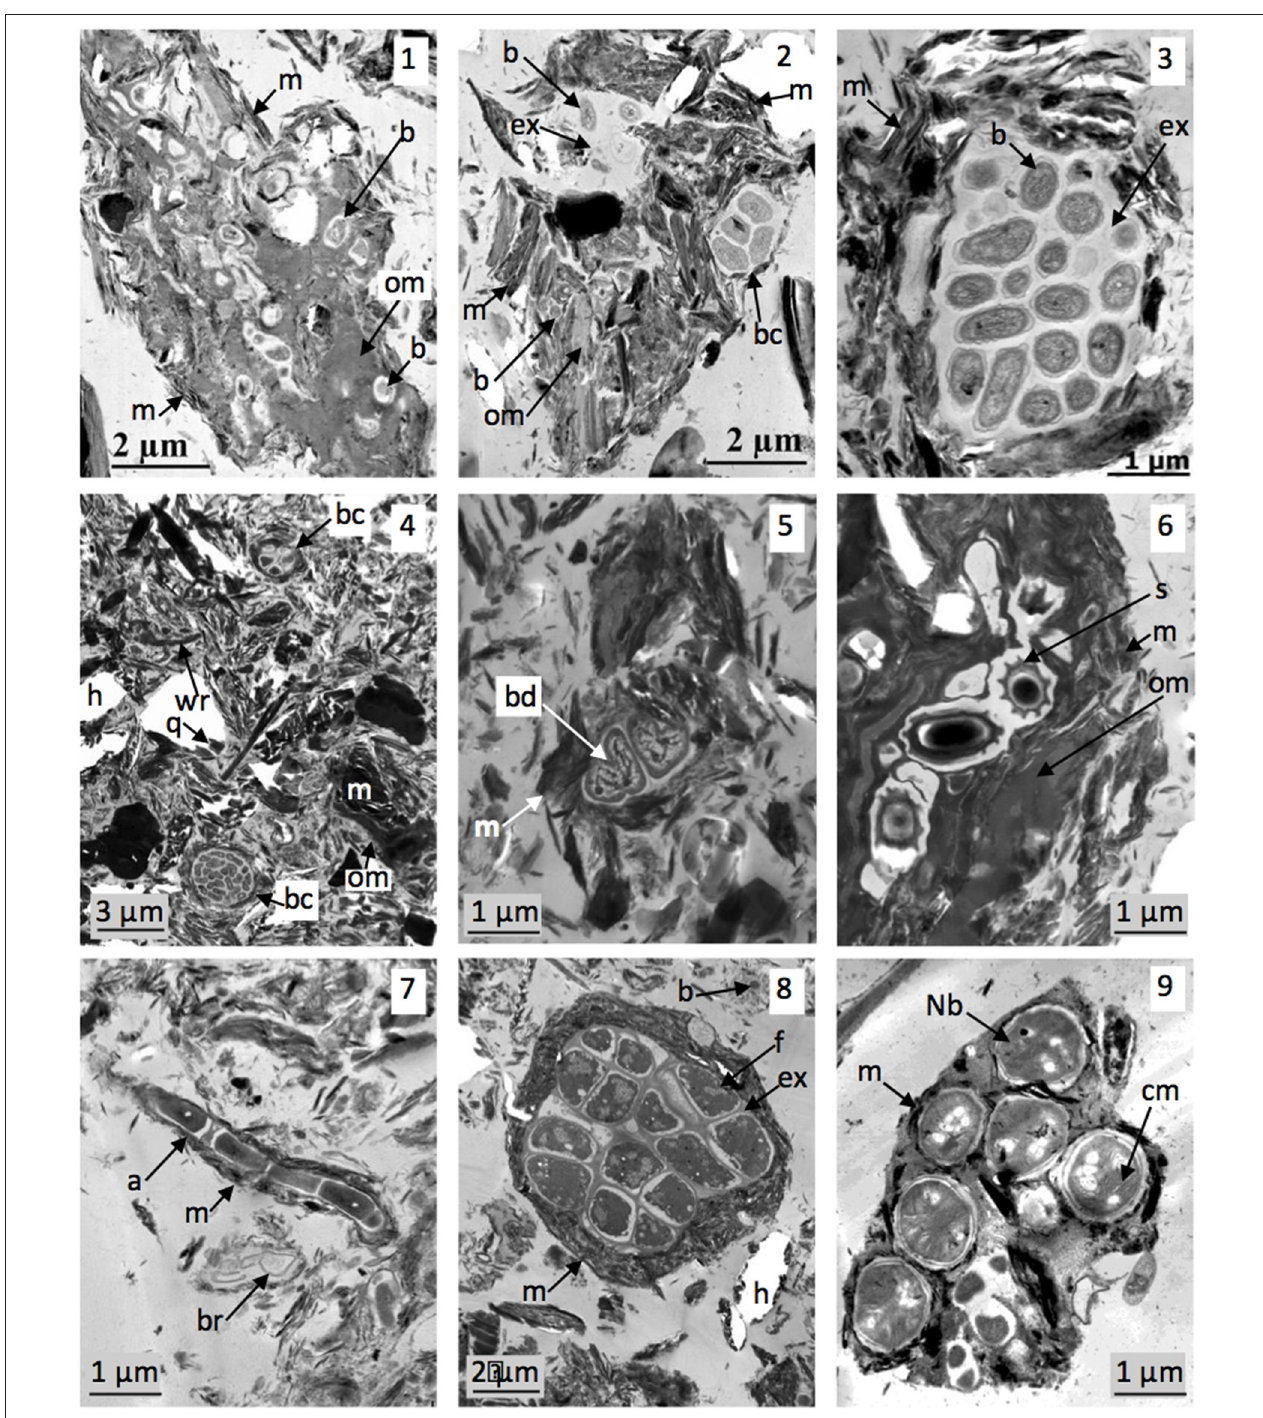
FIGURE 1 | Microorganism localization within soil microstructures. TEM views (1–3) : soil 1 microaggregates (already published in Watteau et al., 2012). (1) Organic residue colonized by bacteria and surrounded by with minerals; (2) mainly mineral aggregate containing few organic residues and EPS producing bacteria (individualized or in colony); (3) typical bacterial aggregate constituted by bacteria producing EPS on which are adsorbed minerals. TEM views (4–6) : soil 2 aggregates. (4) Global view of 2–20 µ m fraction showing mineral or organic particles and bacterial aggregates as bacterial colony associated with minerals. (5) Bacteria in division within aggregate; (6) bacterial spores localized in organic residue associated with minerals. TEM views (7,8) : microorganisms in soil 3. (7) Actinomycete associated with minerals; (8) fungal aggregate. TEM view (9) Bacteria of N cycle in soil 4 (already published in Pey et al., 2014). a, actinomycete; b, bacteria; bc, bacterial colony; bd, bacteria in division; br, bacterial residue; cm, cytoplasmic membrane; ex, EPS; f, fungus hypha; h, hole in the resin as an artifact due to mineral presence; Nb, bacteria of nitrogen cycle; om, organic matter; m, mineral; q, microquartz; s, bacterial spore.